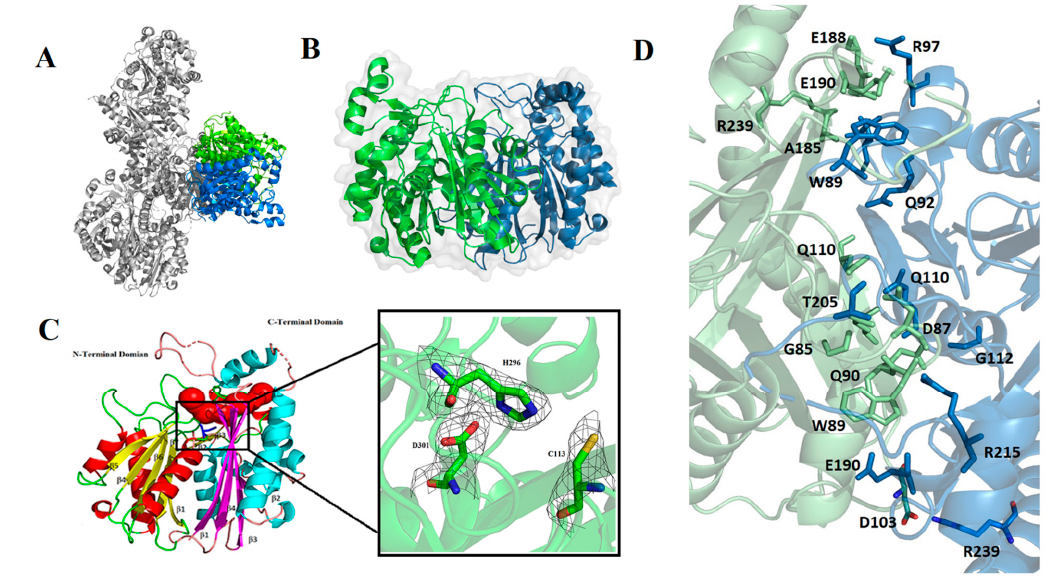
Figure 2. An overview of ChlB3 structure with an active site pocket and conserved residues ( A ) structure of ChlB3 comprising eight monomers. ( B ) surface view of dimeric organization of ChlB3 ( C ) Structure containing αββ ( β ) αββ motifs distributed in two equal parts. The first motif is repre- sented in yellow and red, and second motif is represented in cyan and magenta. Amino acid resi- dues belonging to the c-terminal region are displayed in wheat color and active site pocket is repre- sented in red color, second portion represent the 2Fo-Fc electron density map of ChlB3 conserved residues contoured at 1.0 σ ( D ) A zoomed-in view of the dimeric interface of ChlB3.